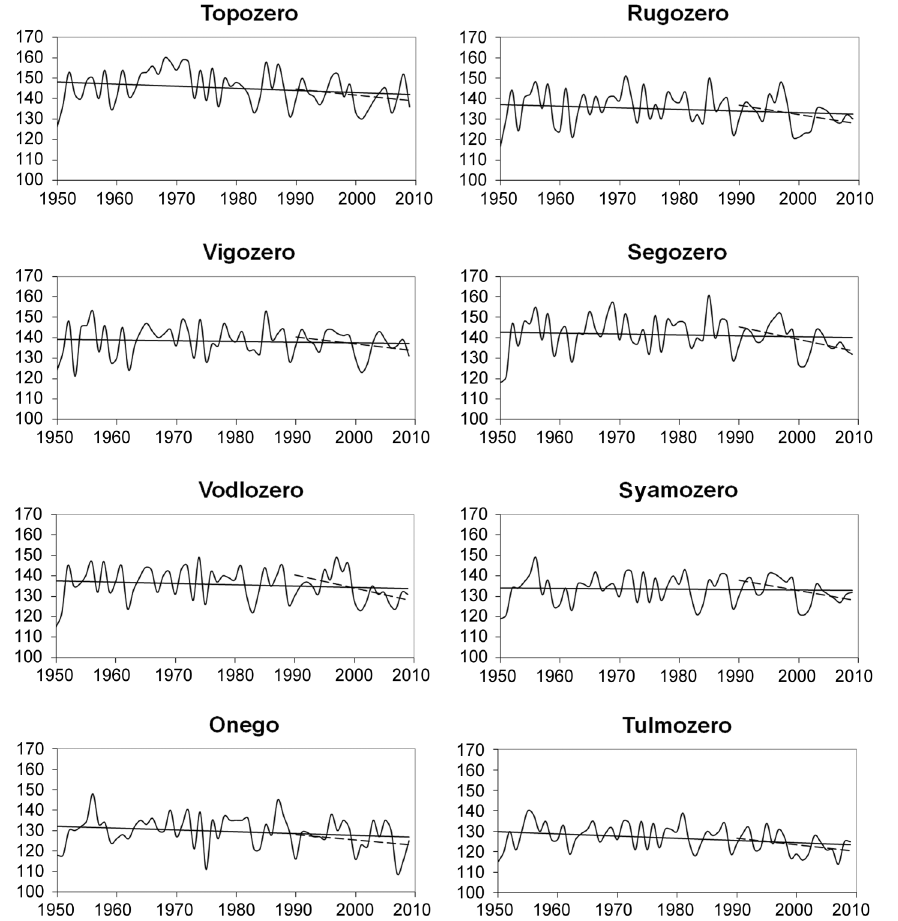
Fig. 4. Dates of ice break-up in